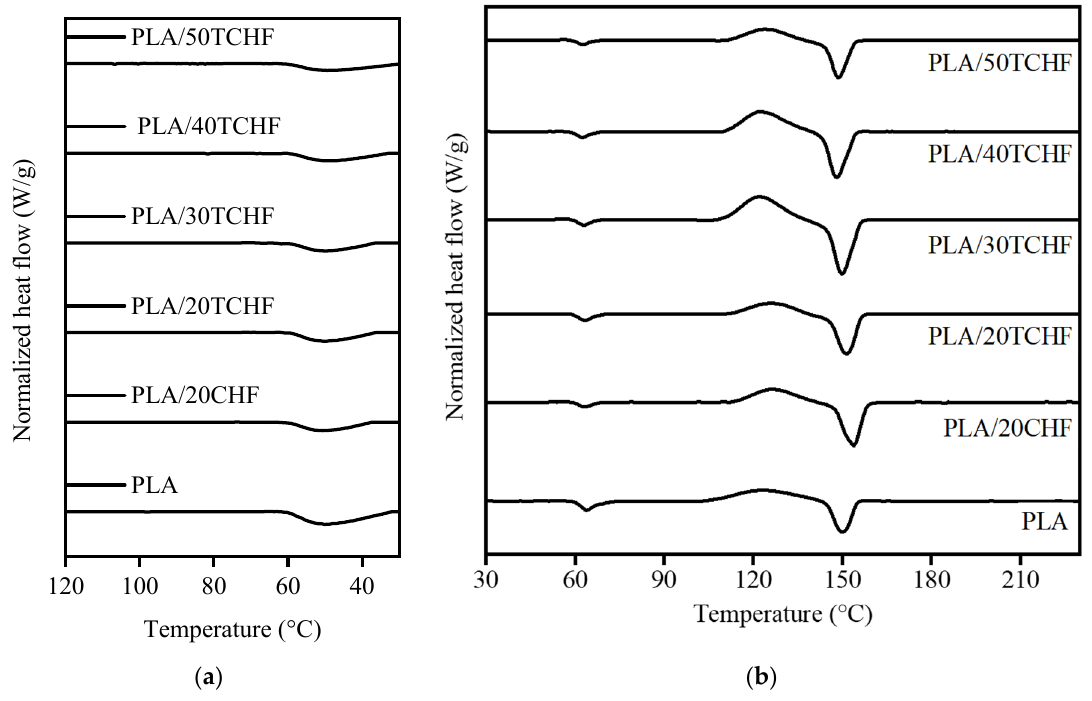
Figure 5. Differential scanning calorimetry (DSC) thermograms taken during ( a ) cooling and ( b ) second heating of the injection-molded pieces of polylactide (PLA) with coffee husk flour (CHF) and torrefied coffee husk flour (TCHF).